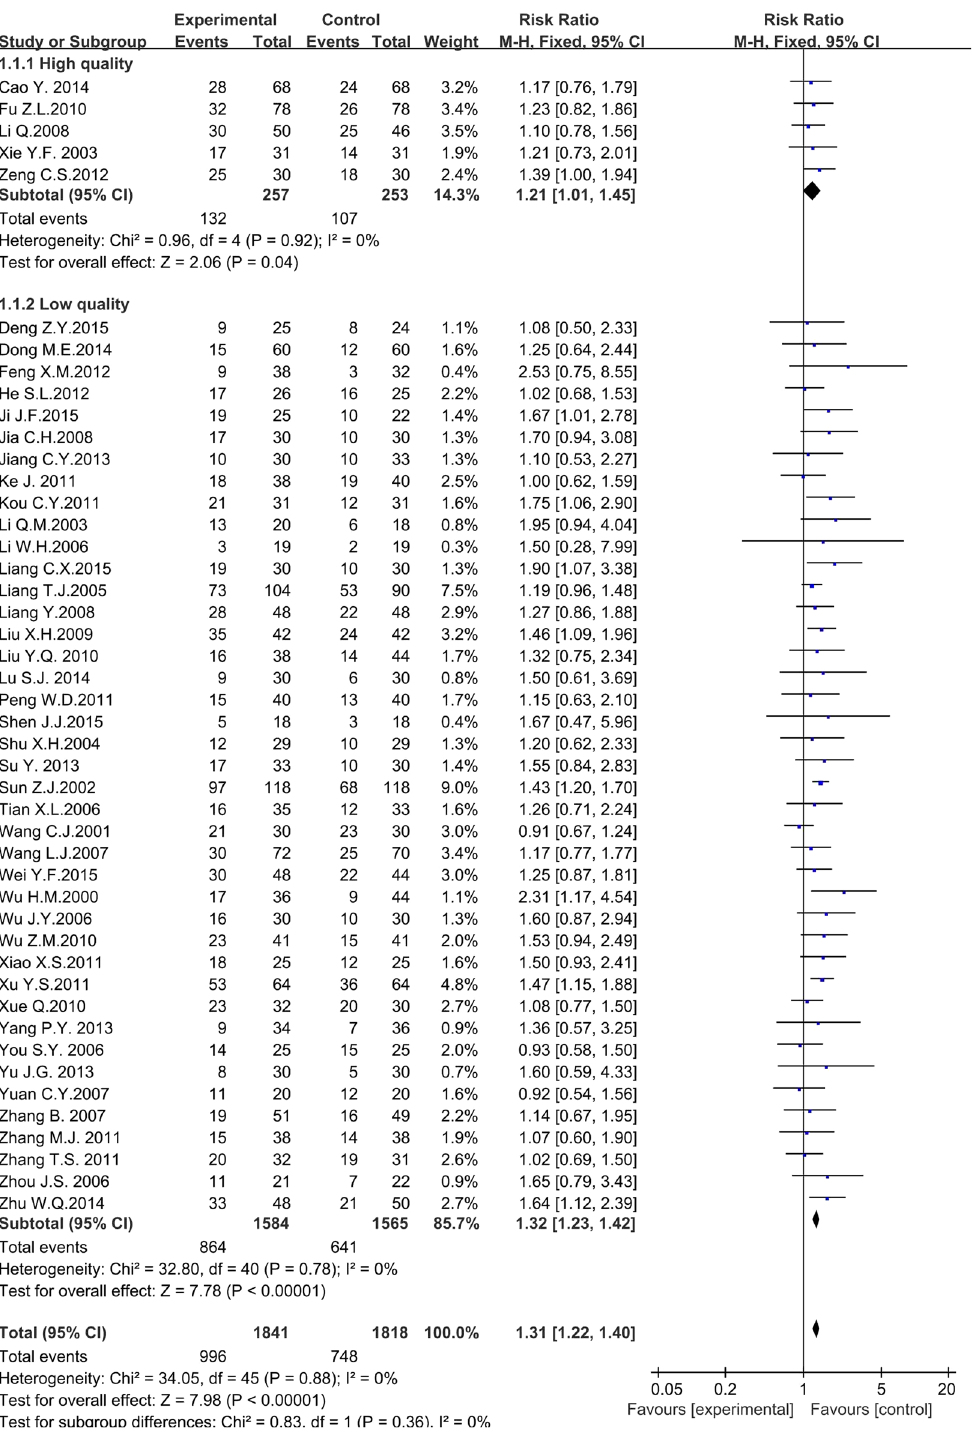
Figure 4. The forest plot of subgroup analysis based on the article’s quality for the objective response rate of traditional insect Chinese medicine and the related preparation combined chemotherapy versus chemotherapy alone ( M-H : Mantel-Haenszel estimates; CI : Confidence